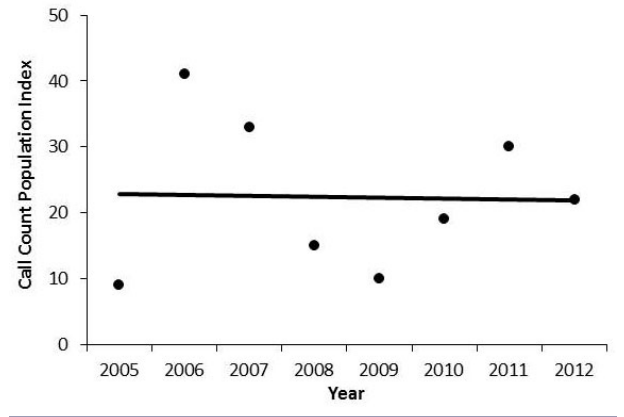
Fig. 6 . California Ridgway’s Rail call-count survey detections and trend (−0.13 birds per year) within Laumeister Marsh. Habitats dominated by invasive Spartina were virtually absent from Laumeister Marsh in all years (not